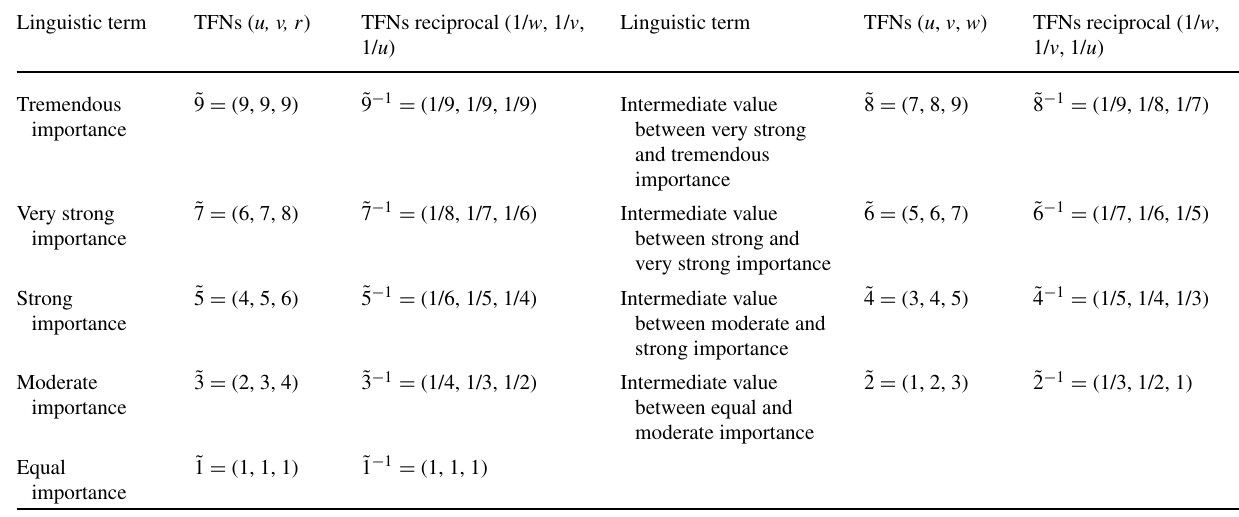
Table 3 Fuzzy linguistic rating scale Linguistic term TFNs ( u, v, r ) Linguistic term